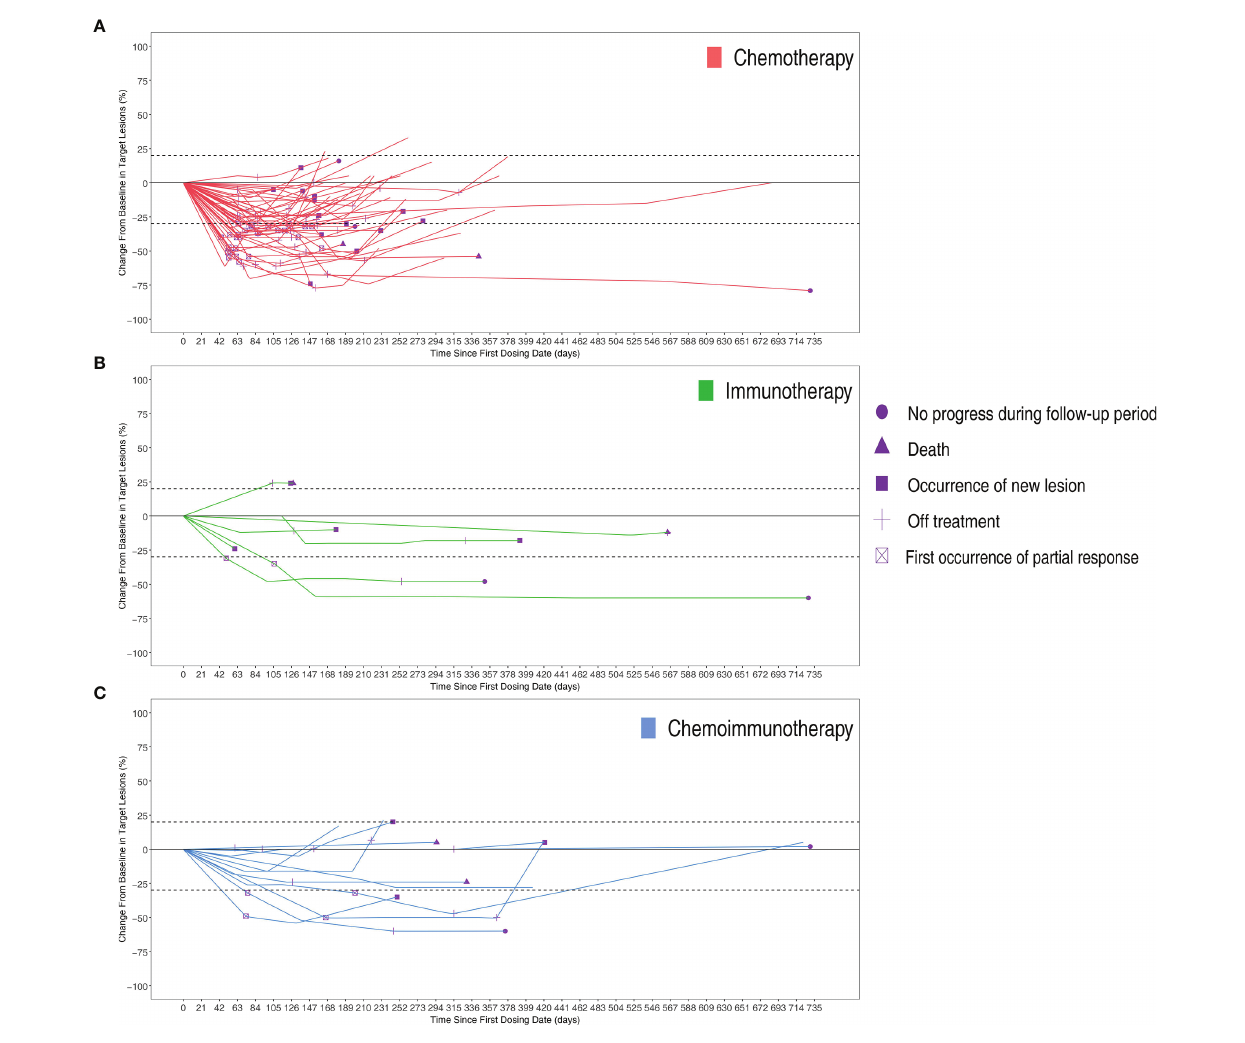
FIGURE 3 | Changes from baseline in target lesions of per patients in three groups over time with (A) Chemotherapy group (B) Immunotherapy group (C) Chemoimmunotherapy